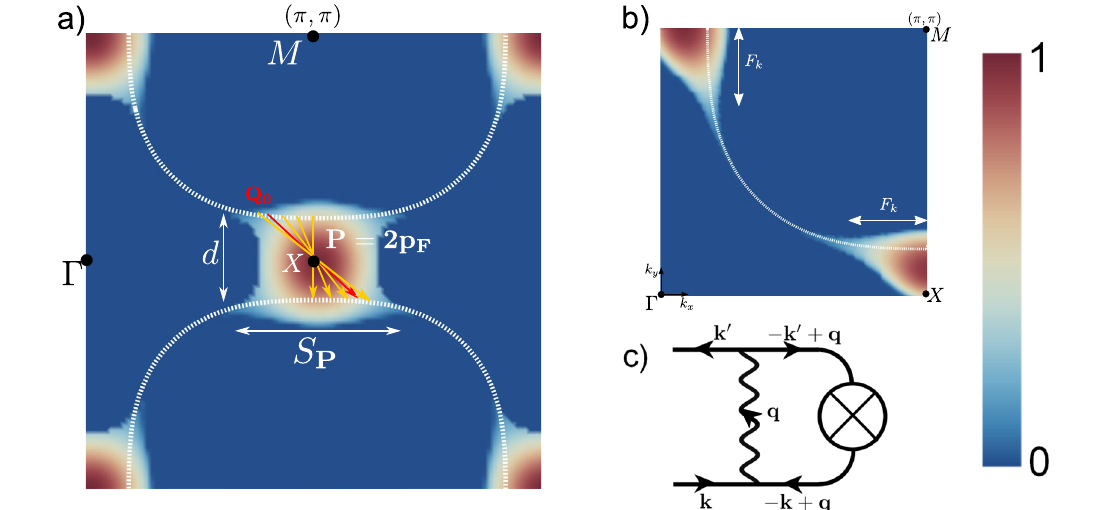
Figure 2. Amplitude of the particle-hole pair patch order parameter χ | | in the first Brillouin zone. ( a ) Color ′ k,k plot of χ | | in the AN zone ( π , 0), as a function of the ordering wave vector q c ( k ′ = k − q c ) (normalized to the ′ k k , maximum value). The amplitude of the electron-hole pair is maximum in the AN region selecting a set of degenerate solutions at 2 p F wave vectors. It is suppressed in the nodal region ( π , π ). We represent the quasi- degenerate 2 p F wave vectors of the electron-hole pairs on opposed Fermi surfaces in the AN region, that give rise to the RES state. The vector Q 0 is the diagonal ordering vector (red vector). The momentum spread is S p . ( b ) Density plot of the particle-hole pair amplitude χ | | for k ′ = k + 2 p F ( k ) (normalized to the maximum value). ′ k k , The size of the gapped zone depends on the magnitude of the interaction π 0 as demonstrated in the Figure S2. Here, the figure are presented for π = 1 , the other parameters are exposed in the SI. ( c ) Feynman diagram 0 representing the χ mean field equation ′ k k ,